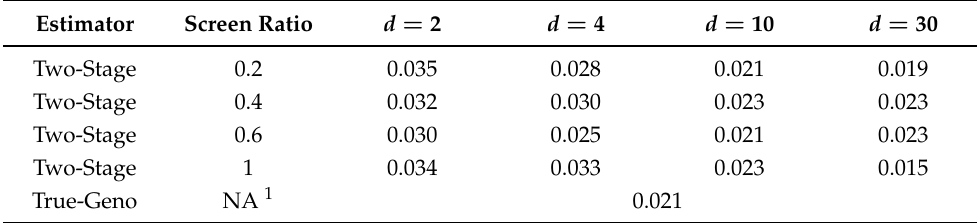
Table 4. Type 1 Errors with Multiple Test Adjustments for Continuous Phenotype with Average Sequencing Depth d = 2,4,10,30 for Two-Stage Estimator and True Genotype-Based